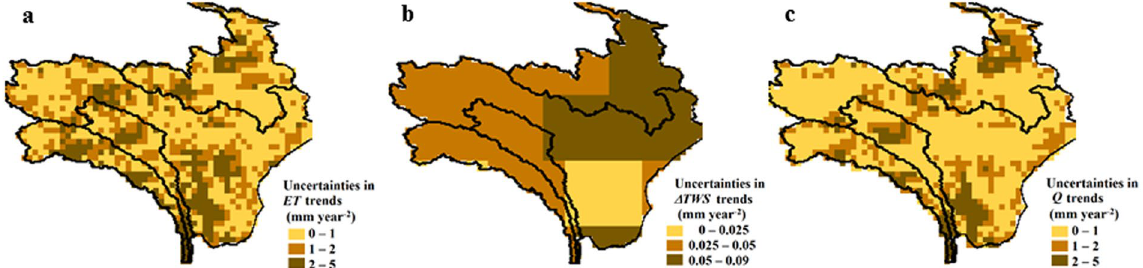
Figure 4. Uncertainties in ET trends, Δ TWS trends, and Q trends for eastern TP region shown in Fig. 1. ( a ), uncertainties in ET trends by considering the standard deviations of four ET products. ( b ), uncertainties in Δ TWS trends by considering the inversion error of mascon TWS . ( c ), uncertainties in reconstructed Q trends. Please note that uncertainties in Δ TWS trends are much smaller than the uncertainties in ET trends or in Q trends. Q trends are less uncertain than ET trends because Q trends are dominated by P trends. The maps were generated using ENVI (v 4.5, https://www.harris.com/solution/envi) © 2017 Harris